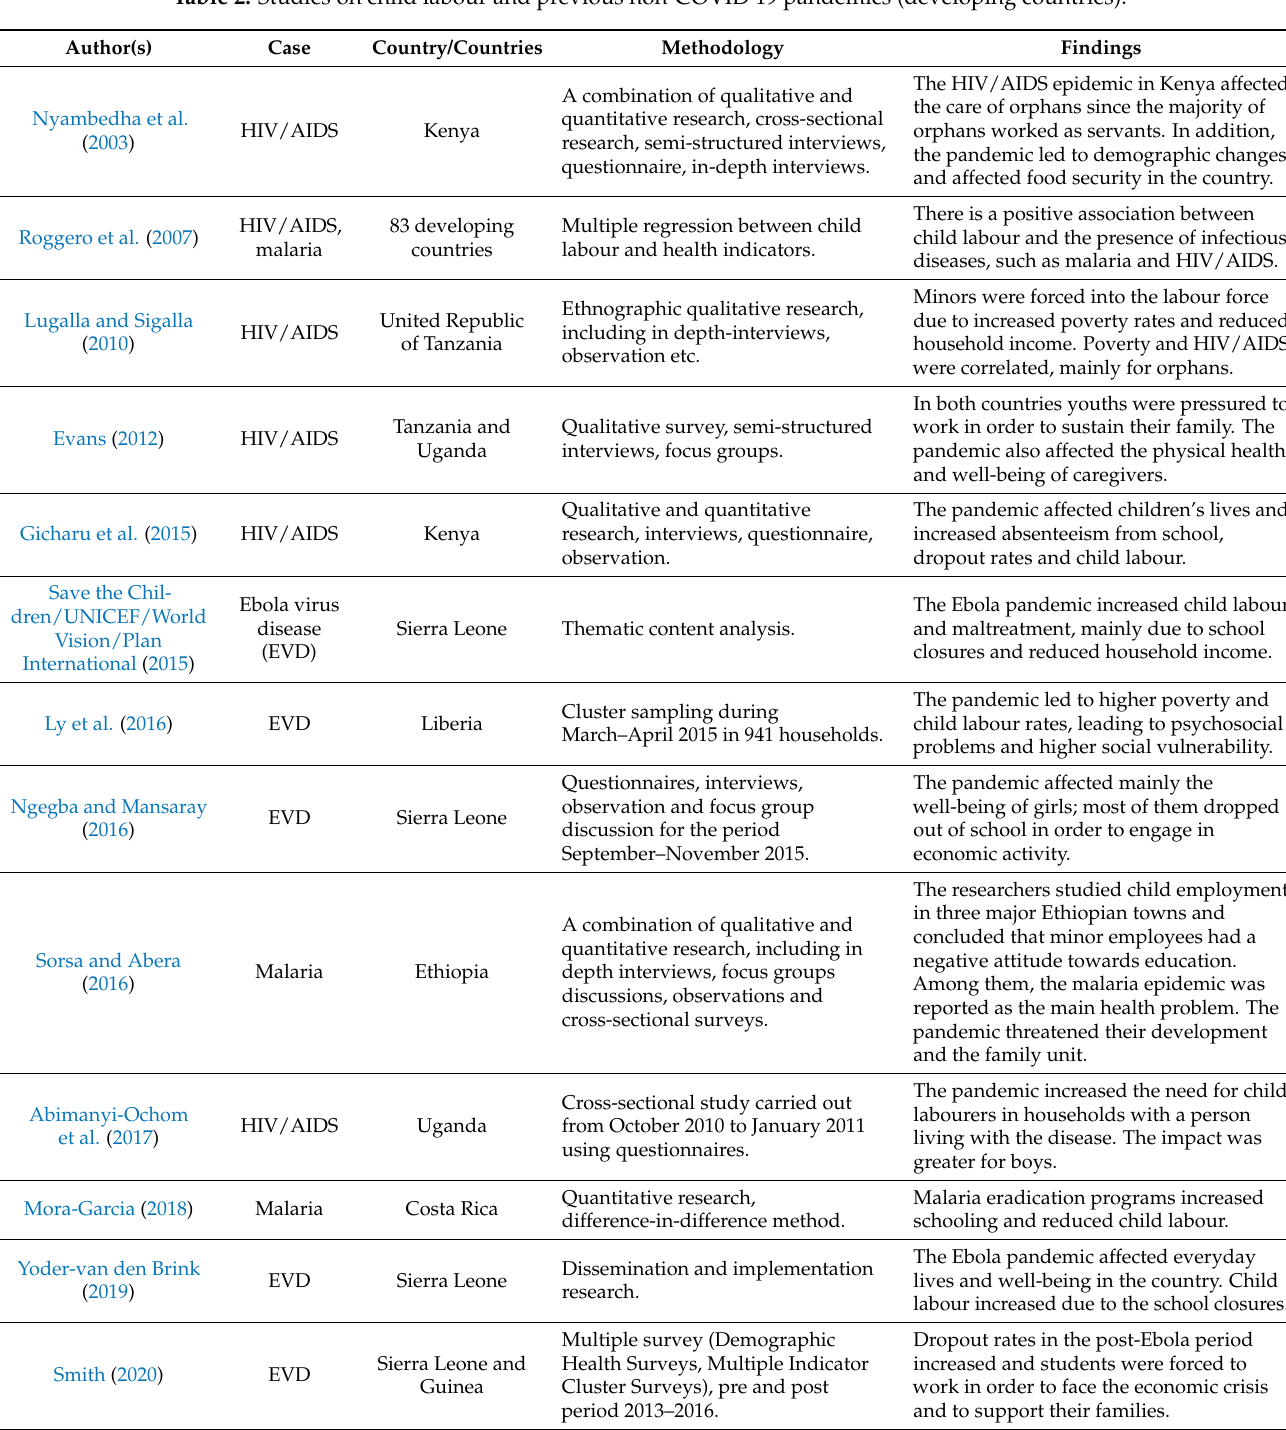
Table 2. Studies on child labour and previous non-COVID 19 pandemics (developing